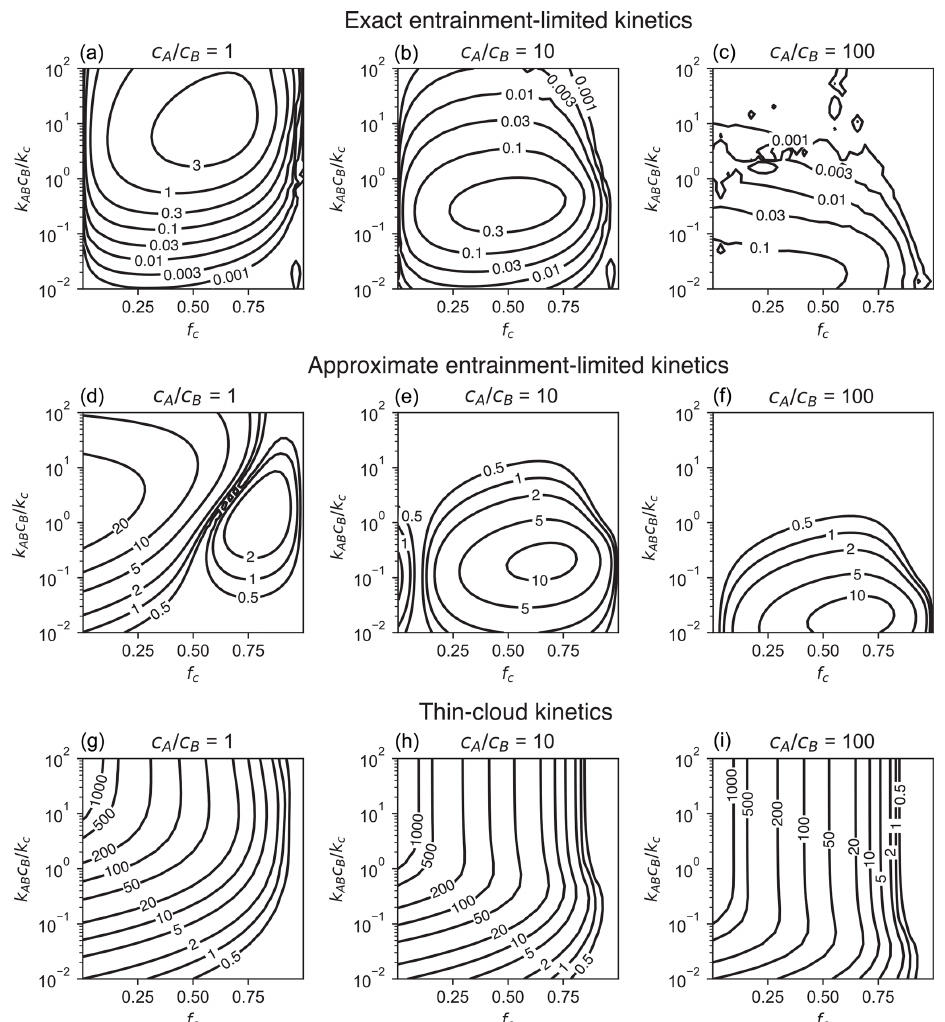
Figure 2. Accuracy of ( a–c ) exact entrainment-limited bimolecular kinetics (Eq. 4), ( d–f ) approximate entrainment-limited kinetics (Eqs. 4a, 7), (g–i) and thin-cloud kinetics. Accuracy is shown as the percent difference (%) in the cumulative loss of reactants after 1h relative to a reference two-box model. For each panel, calculations are performed for a grid of 30 points × 30 points linearly distributed over f c ∈ [0.001, 0.999] and logarithmically distributed over k AB c B /k c ∈ [0.01,